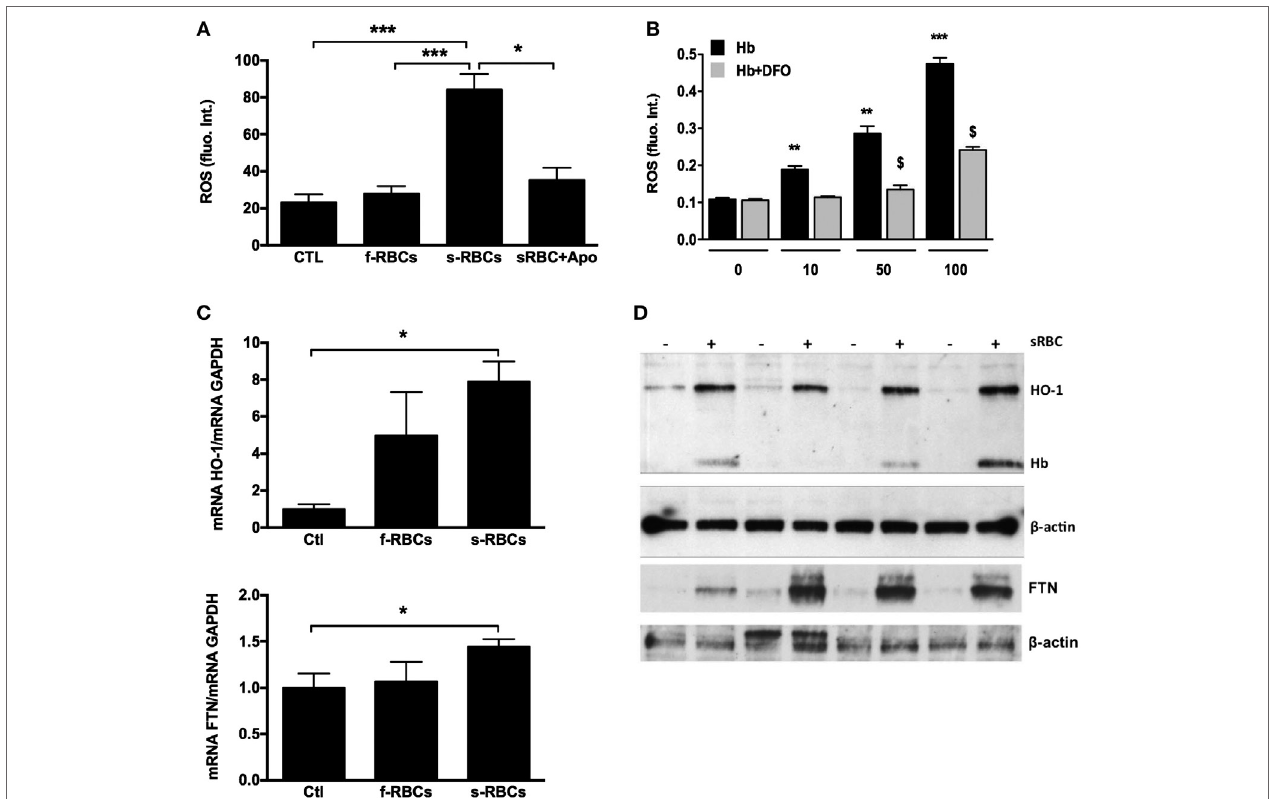
FigUre 7 | Senescent red blood cell (sRBC) phagocytosis induces reactive oxygen species (ROS) production and heme oxygenase-1 (HO-1) and ferritin expression. (a) Vascular smooth muscle cells (vSMCs) were incubated with fresh or RBCs (1 × 10 6 cells) for 3 days ( n = 6), and ROS production was assessed by fluorometry. (B) vSMCs were incubated with increasing concentrations of hemoglobin (0–100 µM) ± desferoxiamine (20 µM) for 2 h ( n = 6), and ROS production was assessed as in (a) . (c,D) HO-1 and ferritin expression in vSMCs after 3 days of incubation with senescent RBCs ( n = 4) were determined by RT-PCR (c) and Western blot (D) . Intracellular hemoglobin content (D) was determined by Western blot.